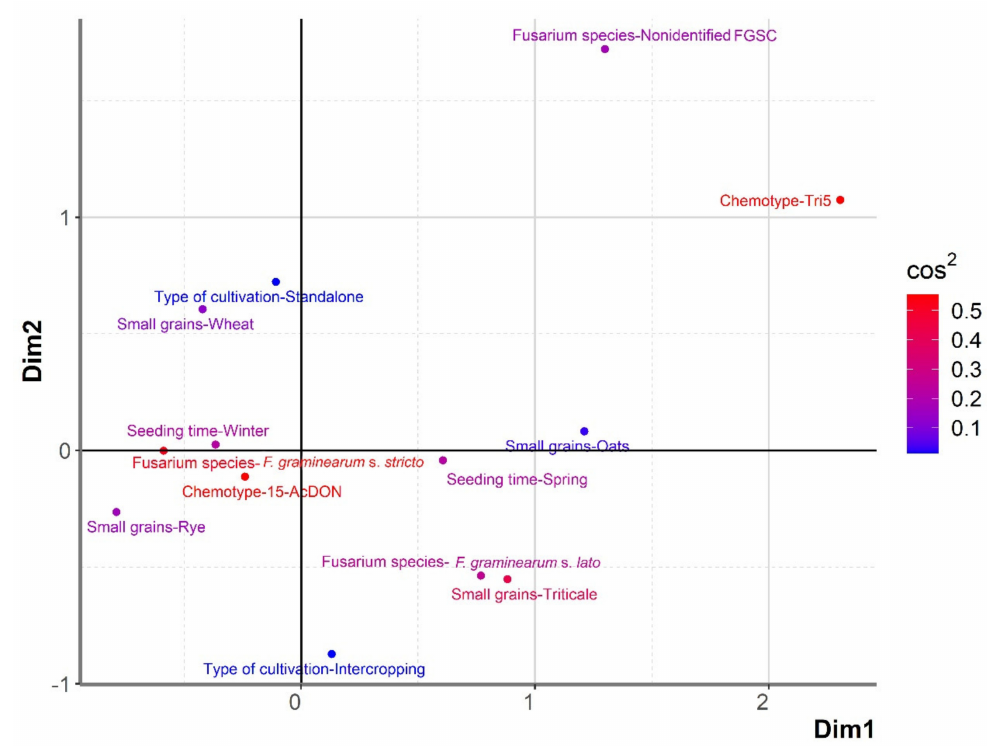
Figure 5. Multiple correspondence analysis (MCA) between cereal crop species (wheat, rye,